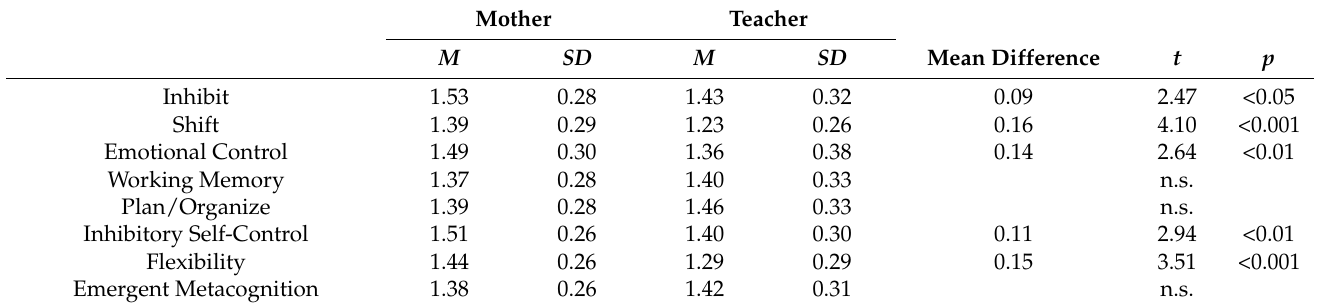
Table 2. Means and standard deviations for mothers’ and teachers’ reports on